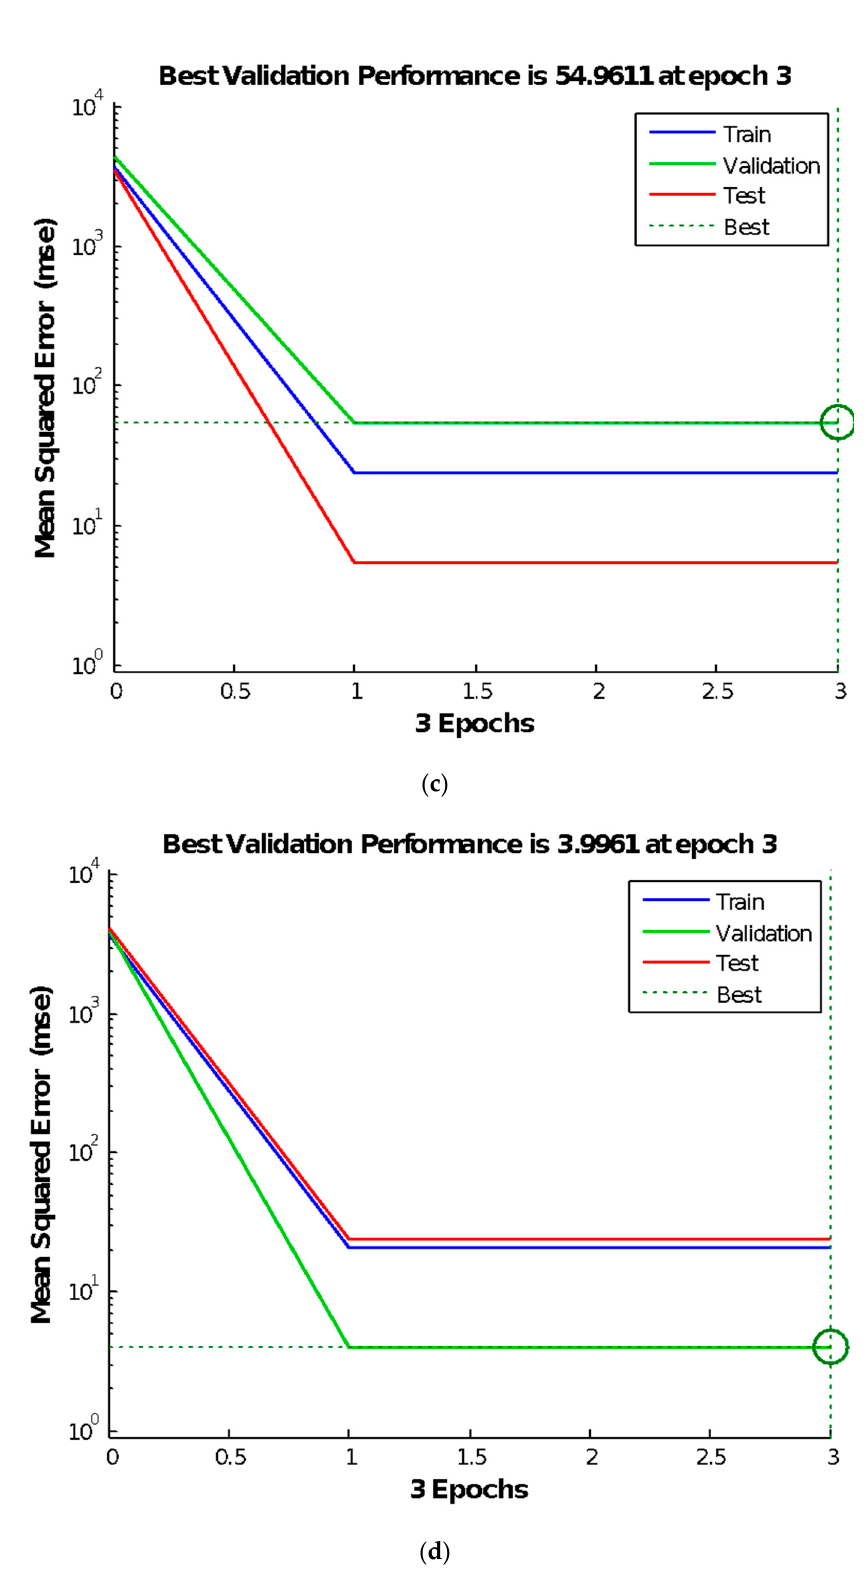
Figure 4. Results of the BP neural network trial test. ( a ) P-4c-k; ( b ) P-7c-k; ( c ) P-10c-k; ( d ) P-13c-k.